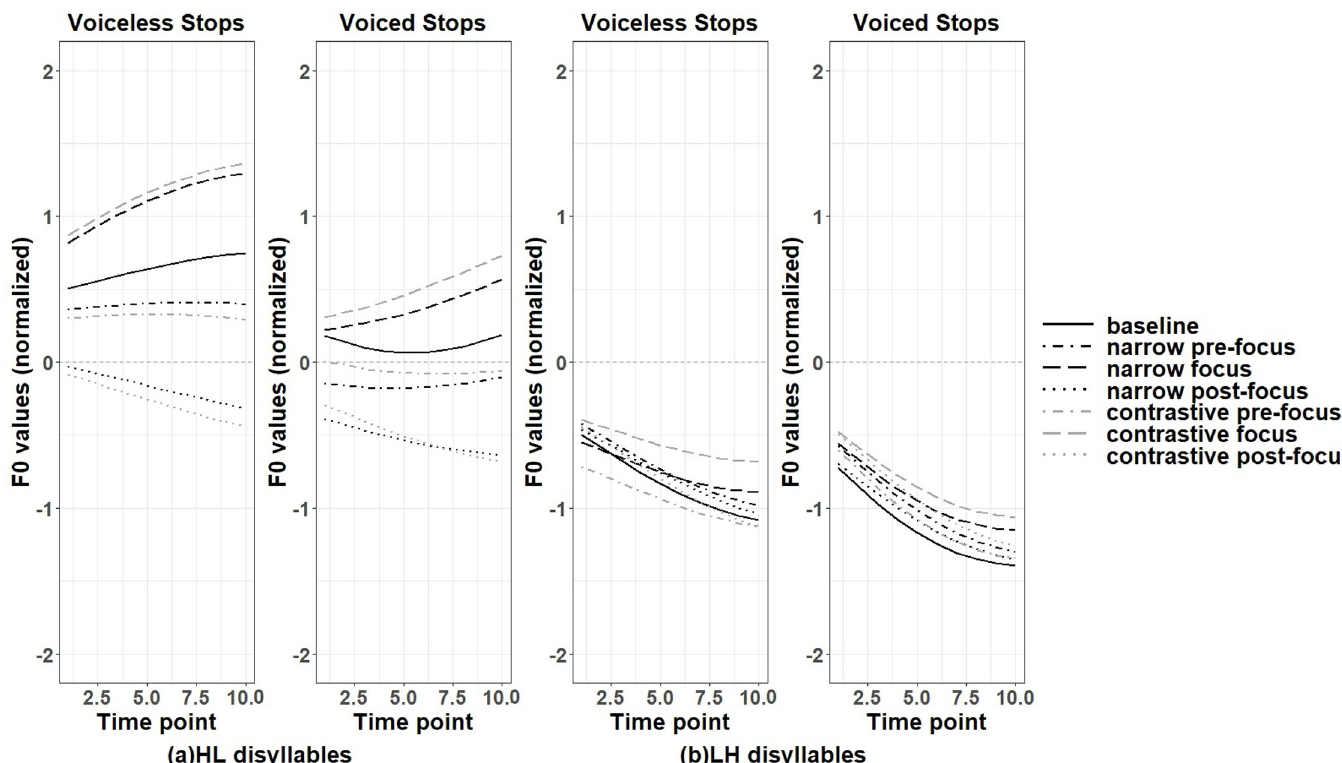
Fig 5. Normalized f0 contours of the first syllable of disyllabic targets in various discourse conditions (Japanese).